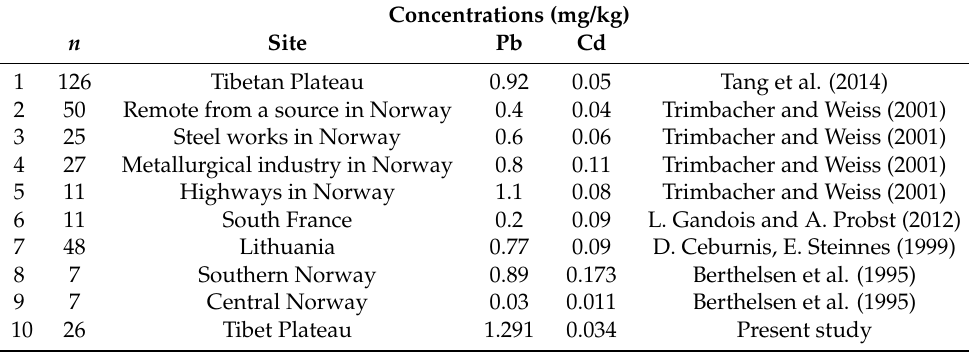
Table 2. The mean concentrations of Pb and Cd in other